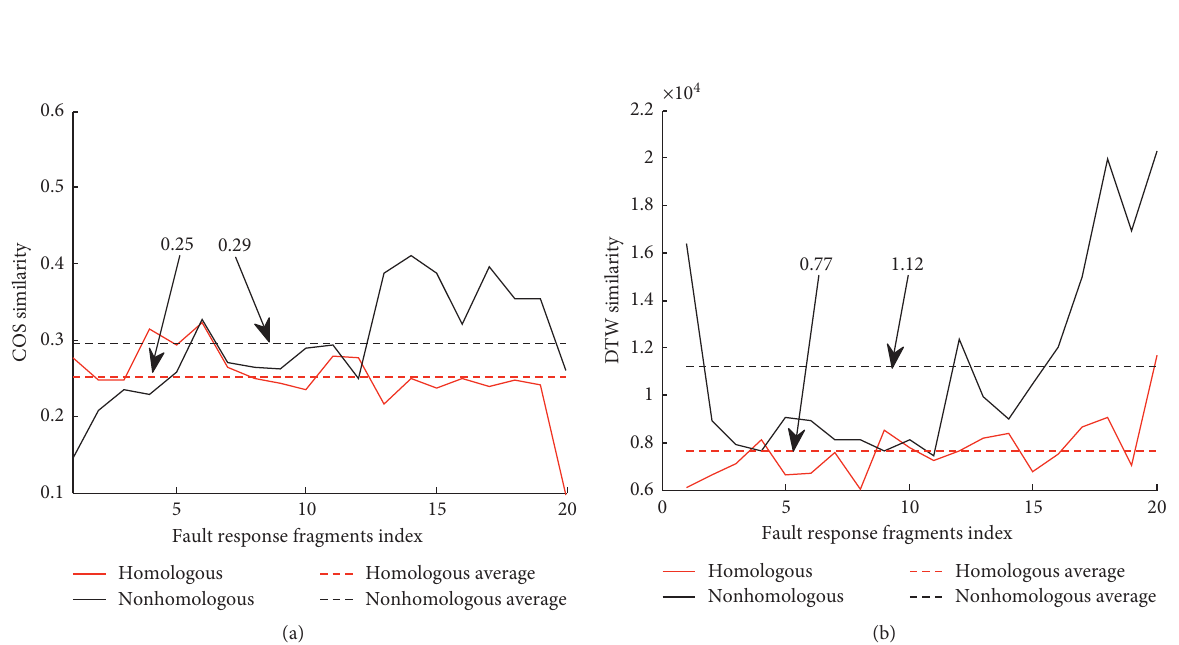
Figure 15: The test results of similarity calculated of comparison methods: (a) OT and (b) DTW.